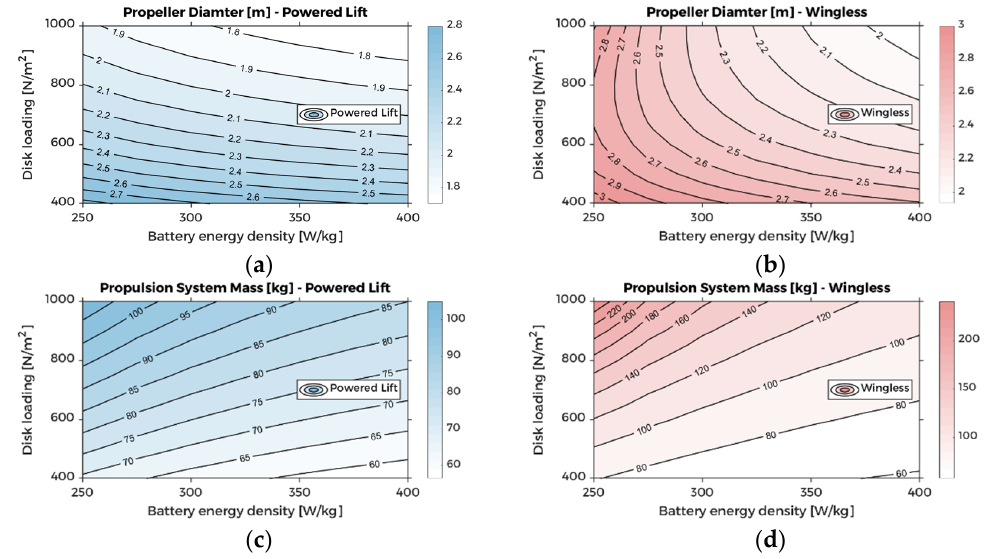
Figure 11. Battery energy density vs. disk loading sensitivity plots for ( a ) powered lift and ( b ) wing- less propeller diameter, and ( c ) powered lift and ( d ) wingless propulsion system mass.